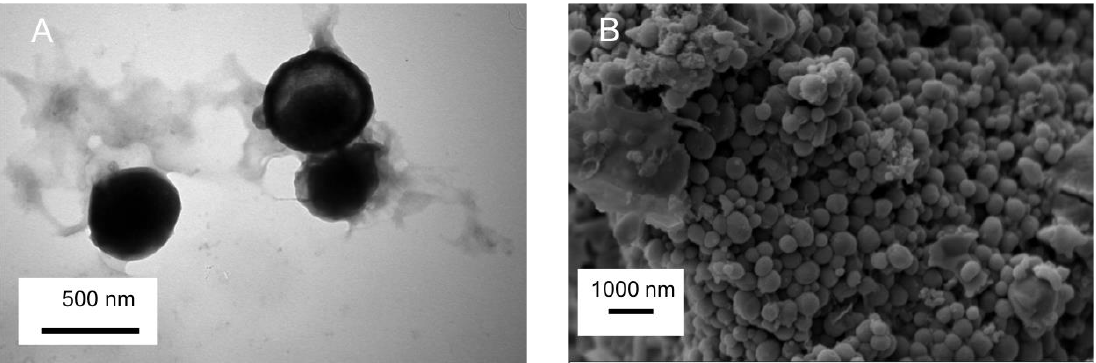
Figure 1. The TEM image of AMSN-CMC-FU ( A ) and the SEM image of AMSN-CMC-FU ( B ).